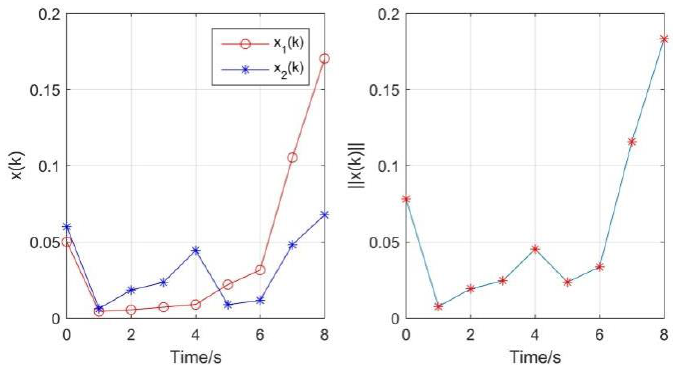
Figure 4. State trajectories of x ( k ) ( left ) and trajectories of (cid:107) x ( k ) (cid:107) ( right ).